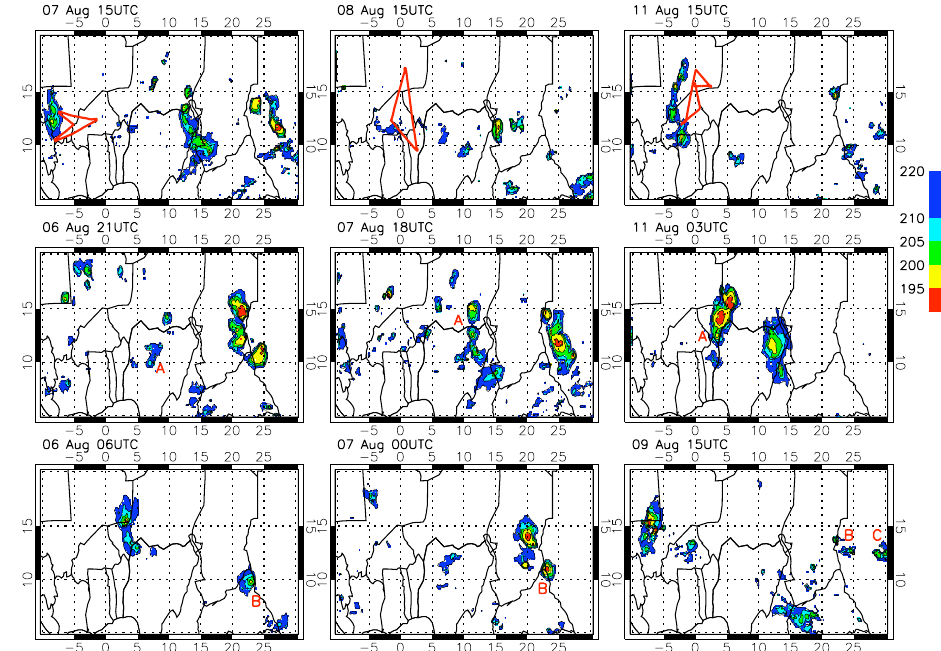
Fig. 1. METEOSAT cloud top brightness temperature time evolution prior to the M55 flight on 7 August 2006 (left panels), 8 August 2006 (central panels), and 11 August 2006 (right panels). Color scale indicates cloud top temperature expressed in K. Flight paths are shown by the red lines; red capital letters identify matches between back trajectories and deep convection as described in the